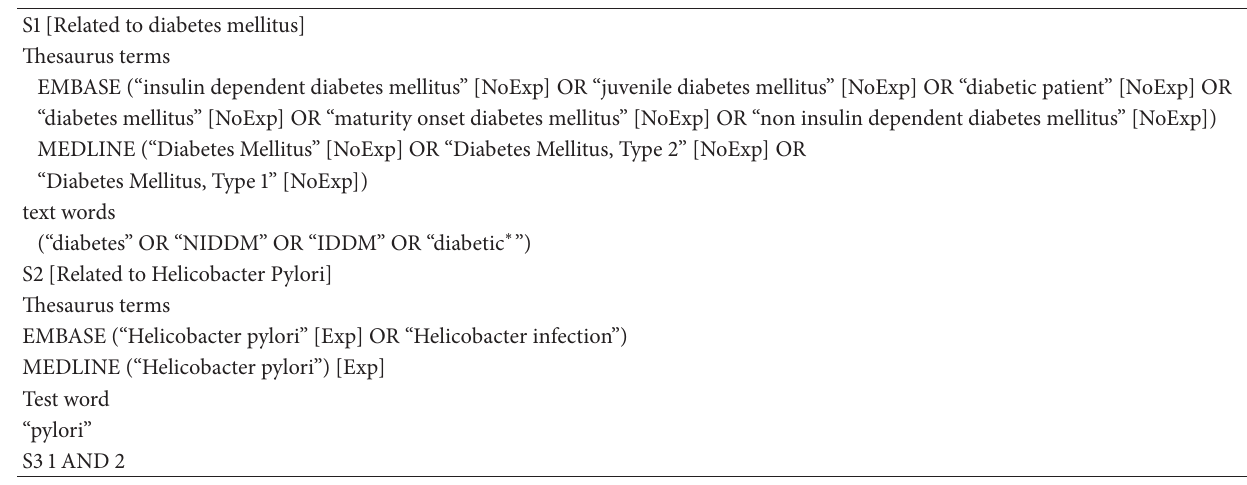
Table 1: Study keywords in this